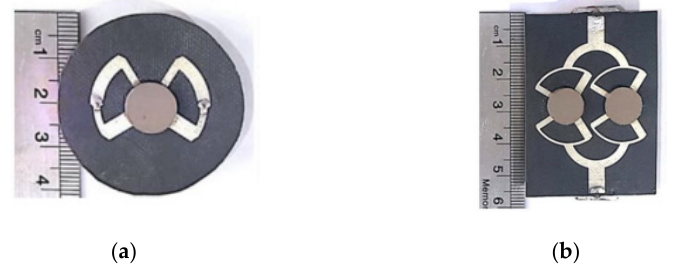
Figure 24. Fabricated prototypes: ( a ) element antenna; ( b ) array [98]. Table 9. Comparison between various DRAs for radar applications. Ref.